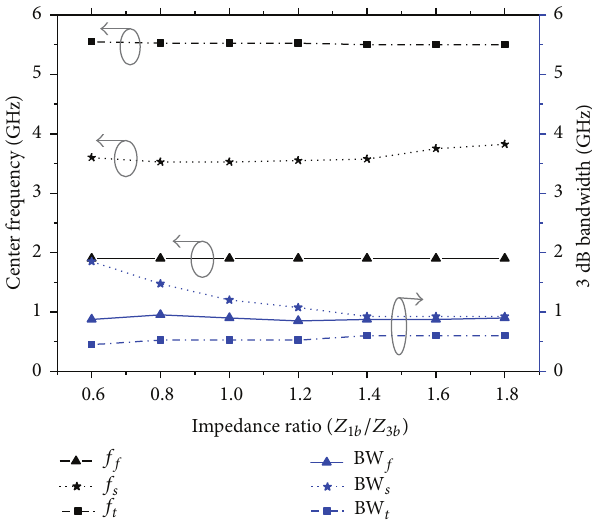
Figure 6: Plot of the variation of the center frequencies and bandwidths of the TBBSF versus the varied impedance ratio for the proposed TSSIR 𝑏 shows that 𝑓 𝑠 and BW 𝑓 can be controlled at almost constant 𝑓 𝑓 , 𝑓 𝑡 and BW 𝑓 , BW 𝑡 ,